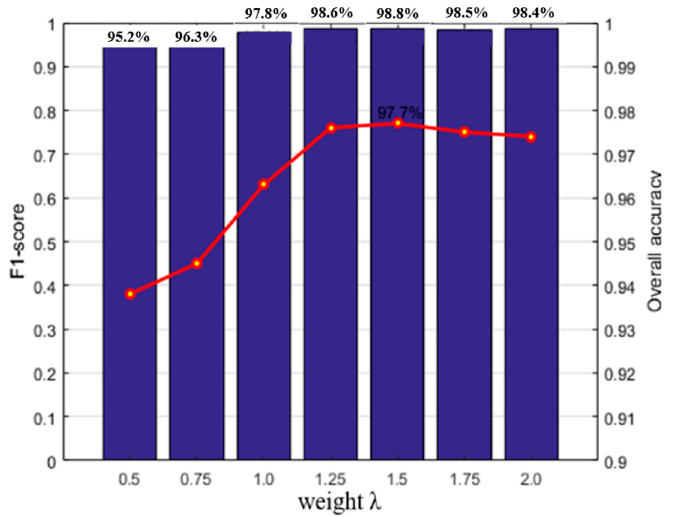
Figure 7. Impact of the weight λ on semantic labeling results.